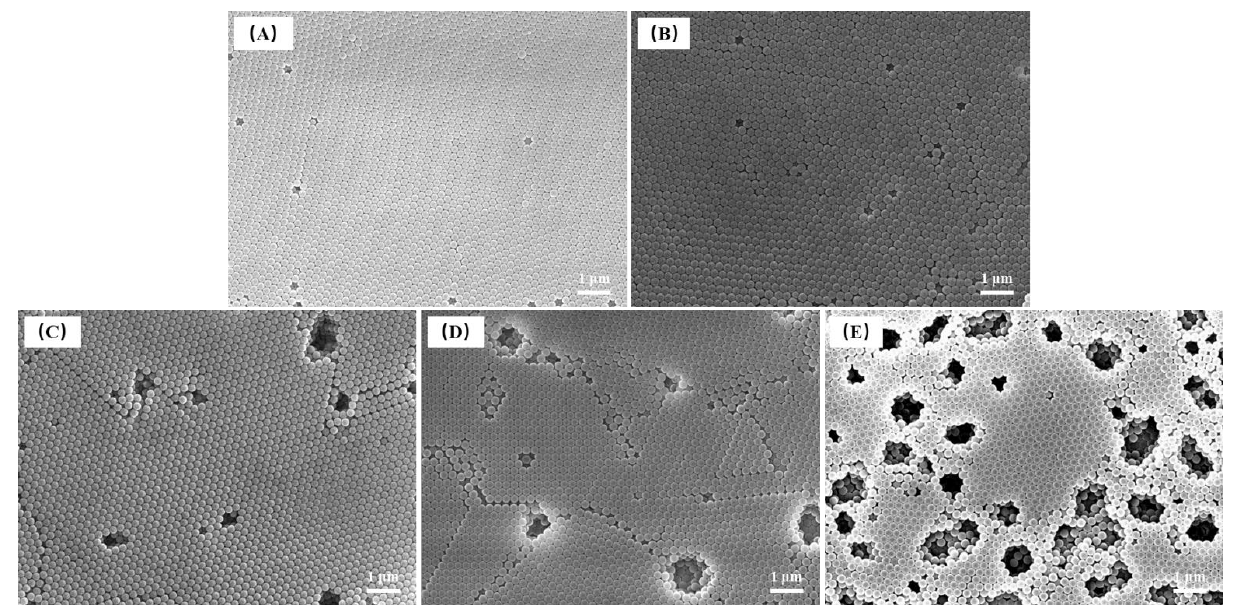
Figure 4. The particle size analysis of P(St-AA) colloidal microspheres synthesized with different amounts of APS: ( A ) by DLS characterization; ( B ) by measuring FE-SEM images. The FE-SEM images of P(St-AA) colloidal microspheres (Figure 5) synthesized with 125 and 150 mg APS, showed that the samples had only point and line defects; however,